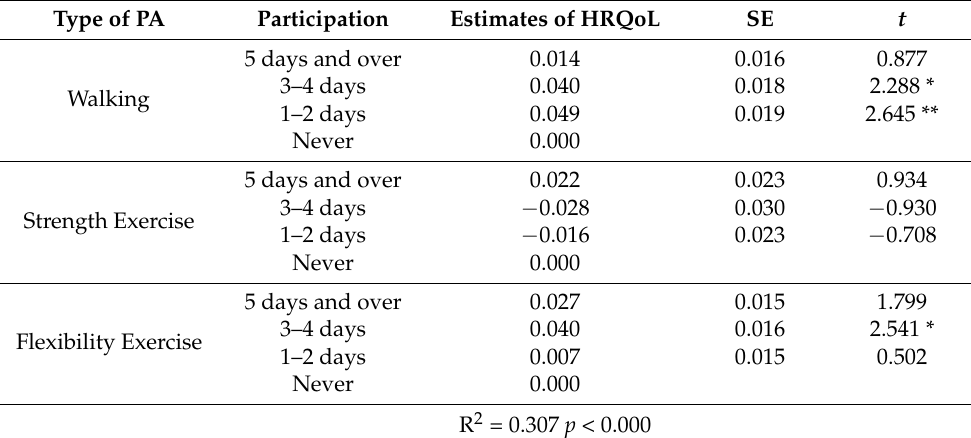
Table 3. Results of the effects of different types of PA (e.g., walking, strength exercise, flexibility exercise) on HRQoL of Korean women with a depressive